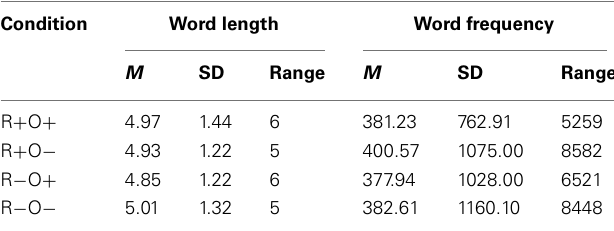
Table 1 | Descriptive statistics of the word stimuli divided by